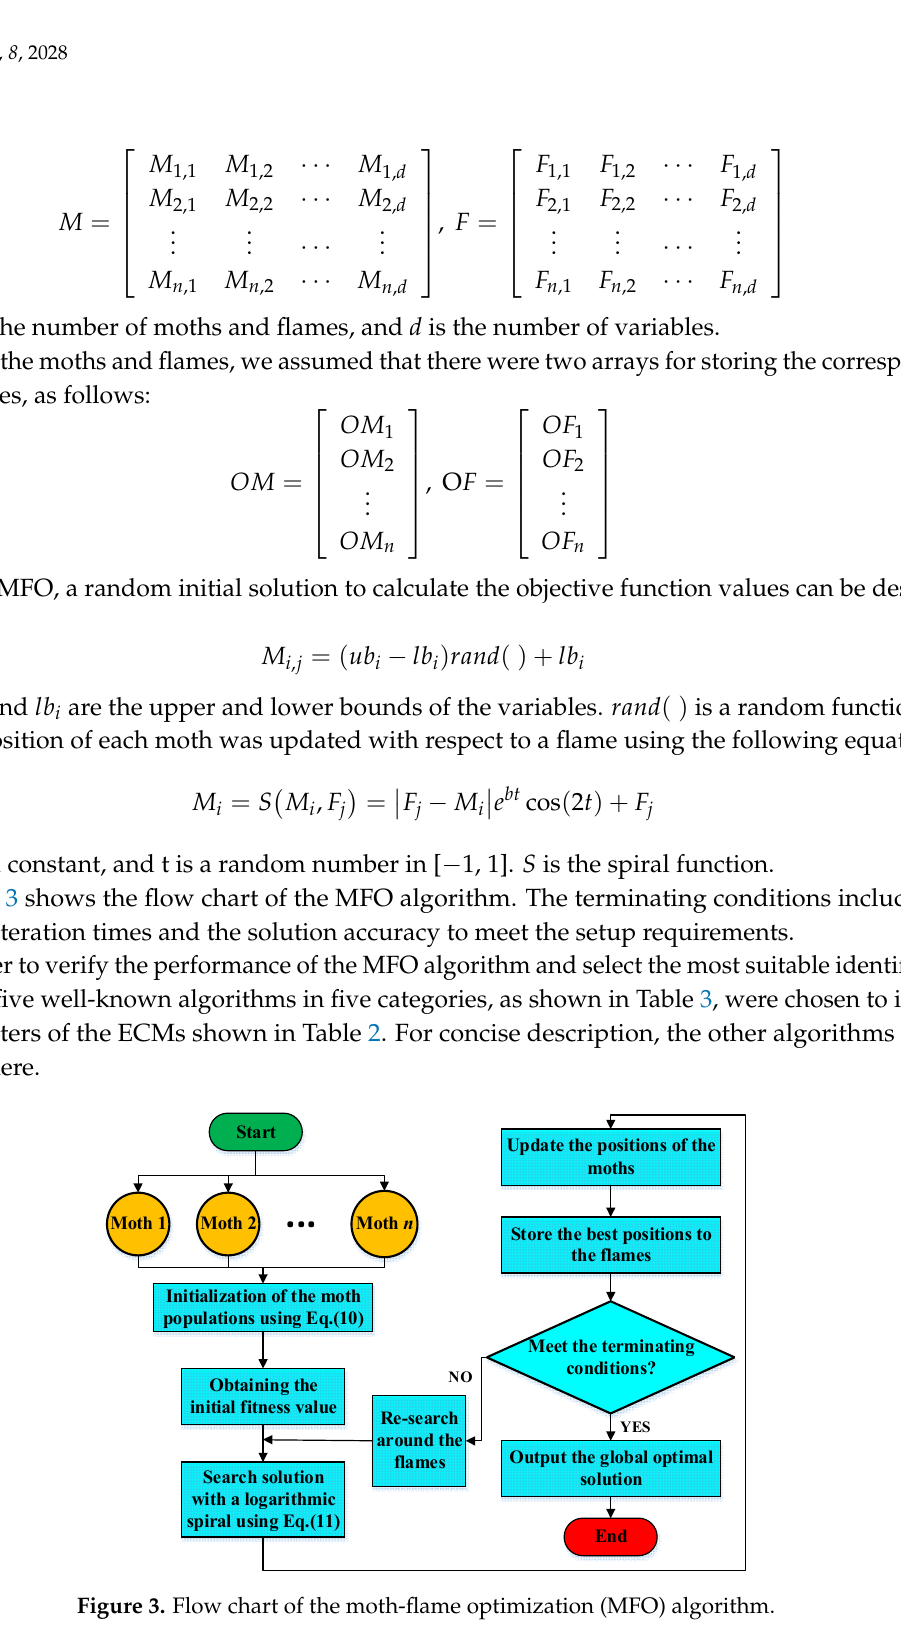
Figure 3. Flow chart of the moth-flame optimization (MFO) algorithm.